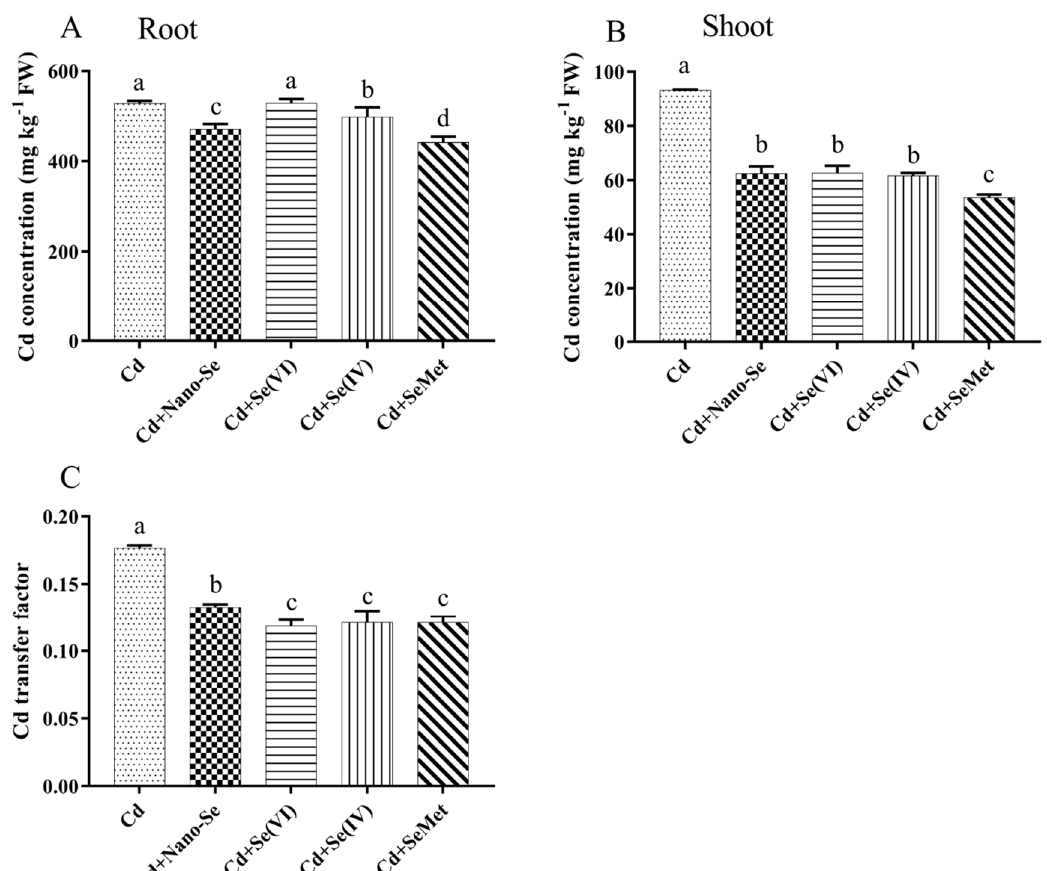
Figure 1. Effects of different Se forms on the Cd concentration in the roots ( A ) and shoots ( B ) and Cd transfer factor ( C ) in rice seedlings in the presence of Cd. Data points and error bars represent mean values ±SD ( n = 3). The different letters indicate statistically significant differences between the treatments at p < 0.05 .